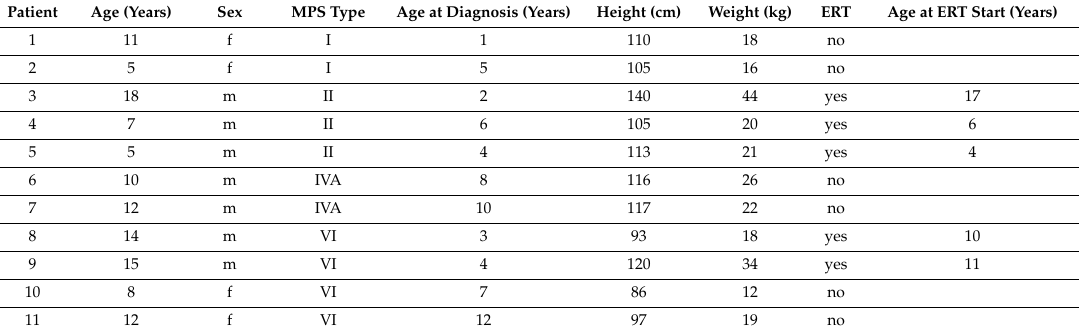
Table 3. Clinical characteristics of the study group.